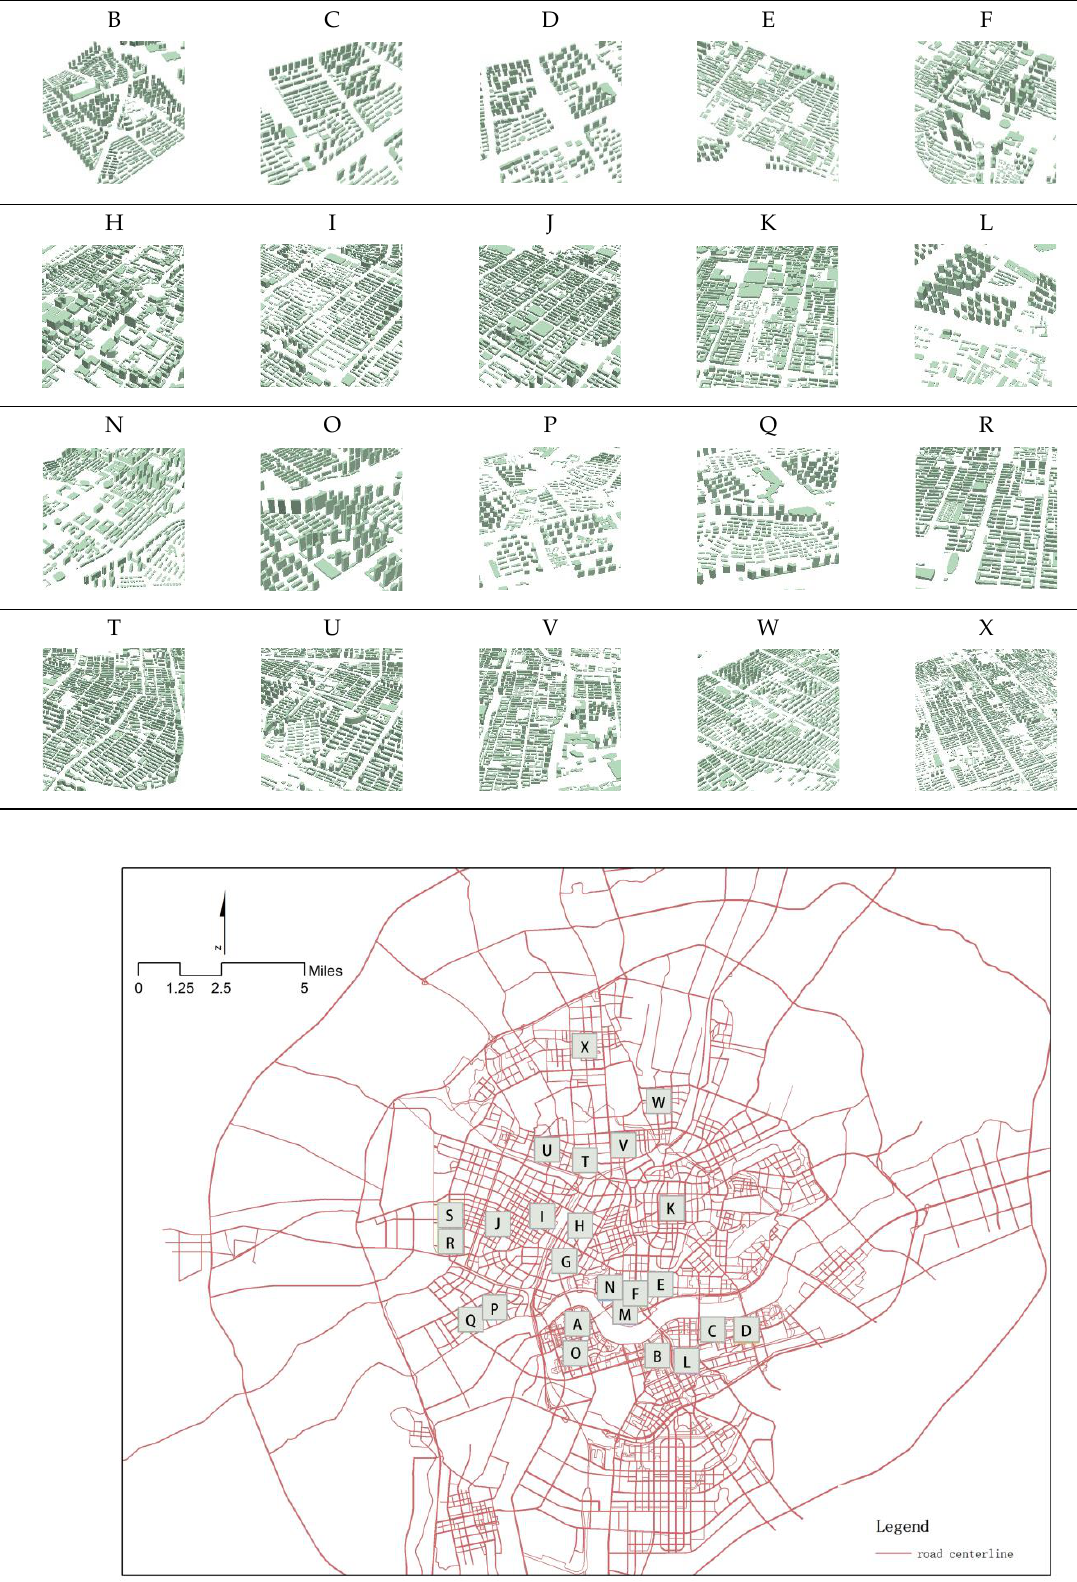
Figure 3. Visual accumulation of urban three-dimensional form from sample area L to sample area F. Source: Visual China Group.